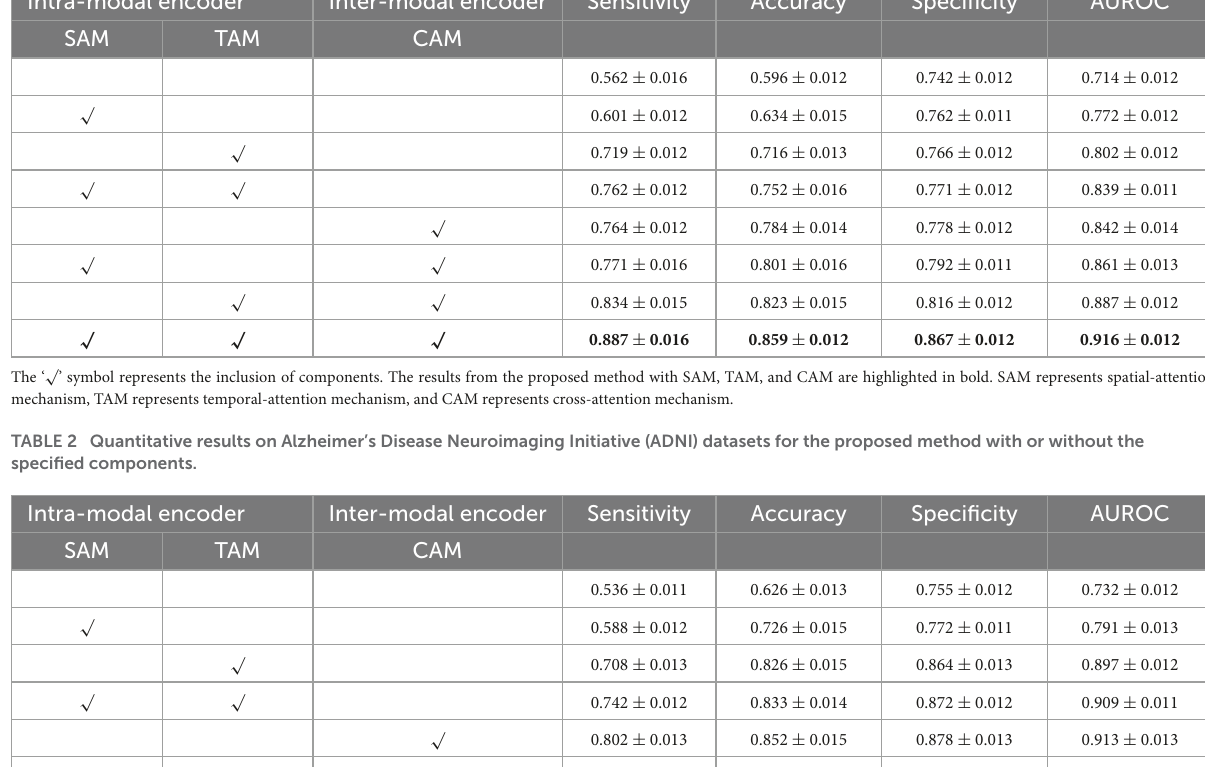
TABLE 1 Quantitative results on internally collected diabetes mellitus (DM) datasets for the proposed method with or without the specified components. Intra-modal encoder